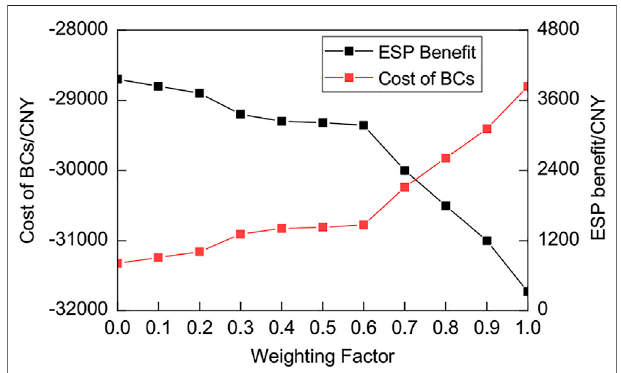
FIGURE 14 | Impact of reward weight factor on economic dispatch